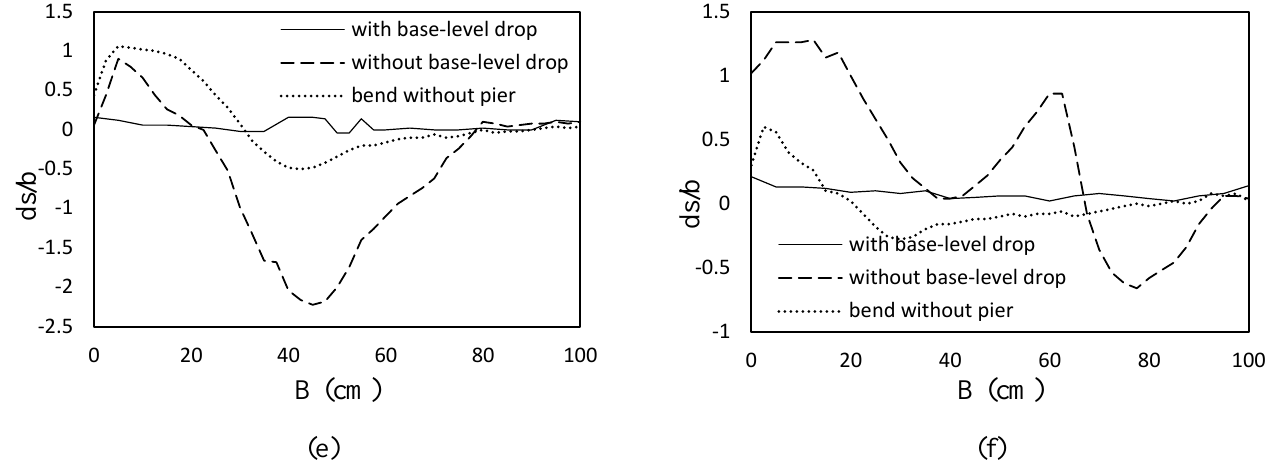
Figure 9. cross sections of a) the beginning of the bend, b) 17 times the pier width at the upstream side of the pier (65 degrees), c) 3 times the pier width at the upstream side of the pier (85 degrees), d) the pier nose, e) 3 times the pier width at the downstream side of the pier (95 degrees), and f) 17 times the pier width at the downstream side of the pier